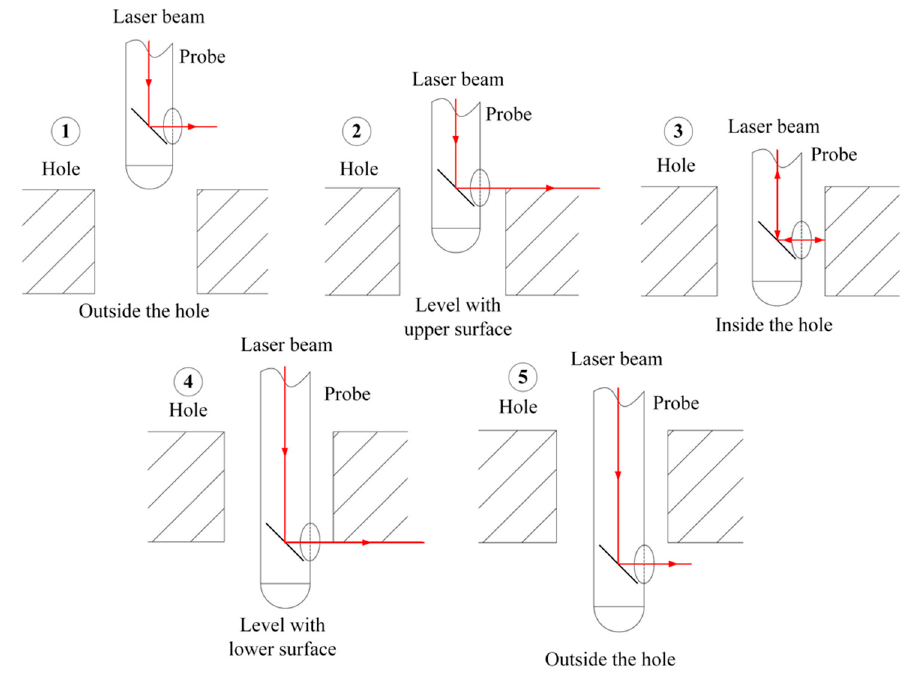
Figure 1. Schematic diagram of the probe movement process.